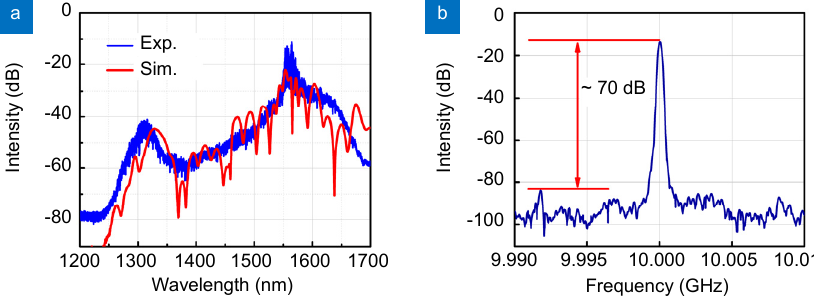
Fig. 8 | ( a ) The simulated and measured SC from the fluorotellurite fiber with the ZDW of 1452 nm and the peak pump power of 387 W. ( b ) RF spectrum from the generated 1310 nm dispersion wave in the fluorotellurite fiber (RBW=200 kHz and VBW=50